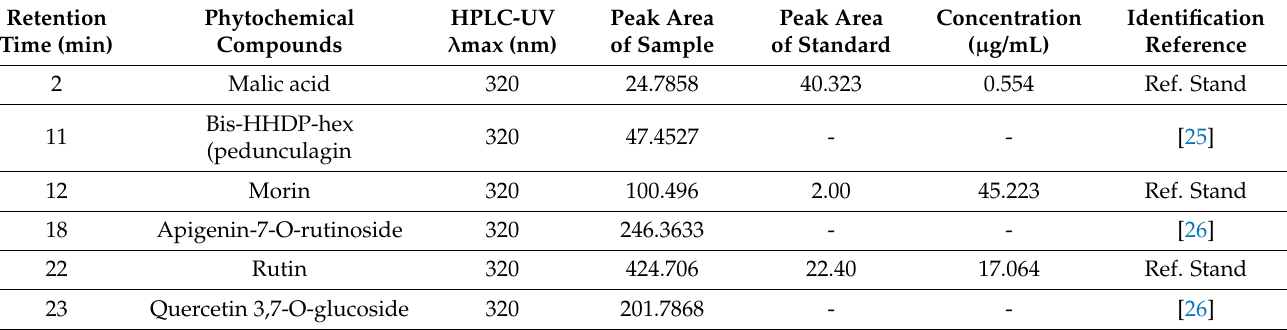
Table 5. Identified phytochemicals in fraction C of A. articulata through the HPLC-UV